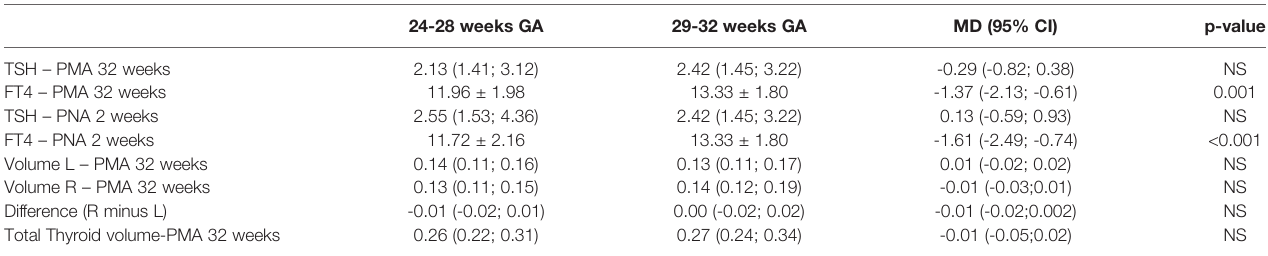
TABLE 2 | Thyroid parameters between groups categorized by GA.